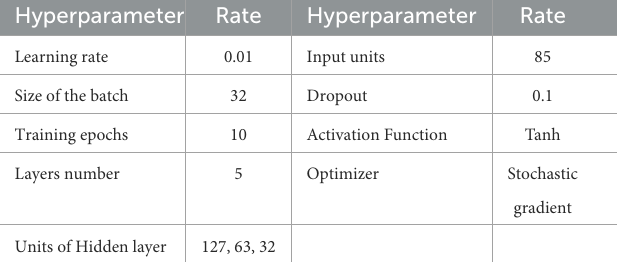
TABLE 5 Parameters of DNN.